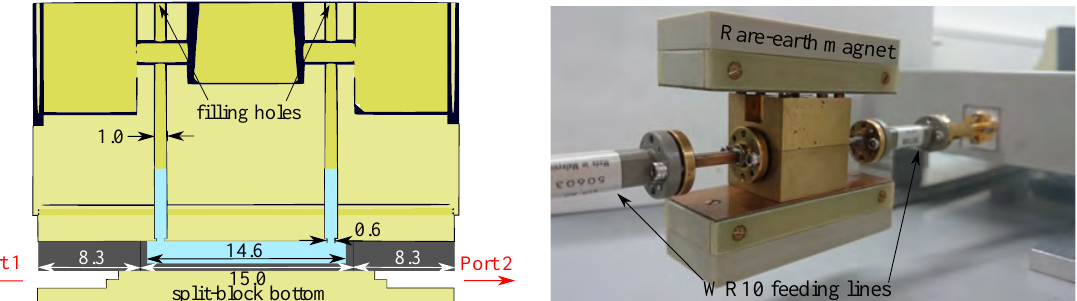
Figure 16. (Left) Cross section and (right) measurement setup for the magnetically biased W-band Figure 16. ( Left ) Cross section and ( Right ) measurement setup for the magnetically biased W-band rectangular waveguide phase shifter. rectangular waveguide phase